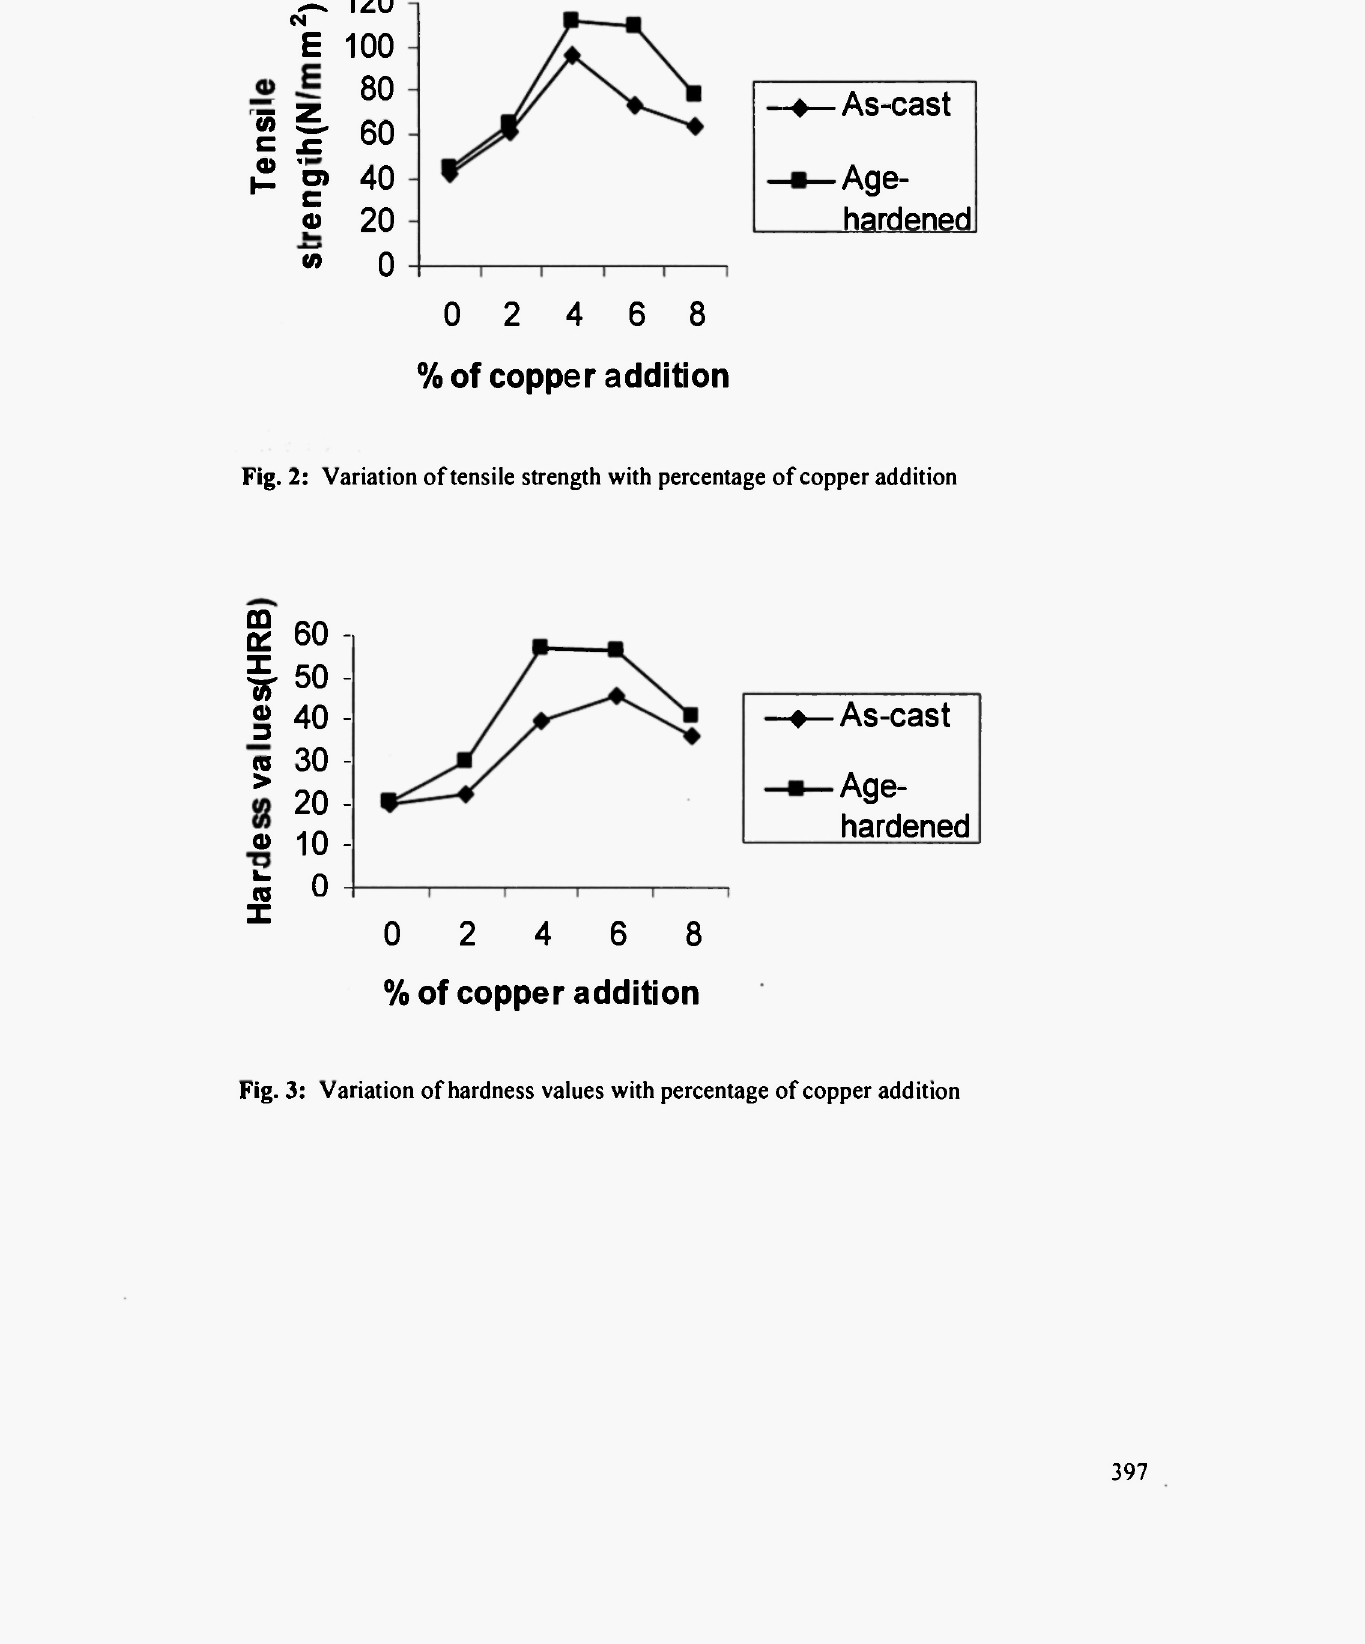
Fig. 2: Variation of tensile strength with percentage of copper addition